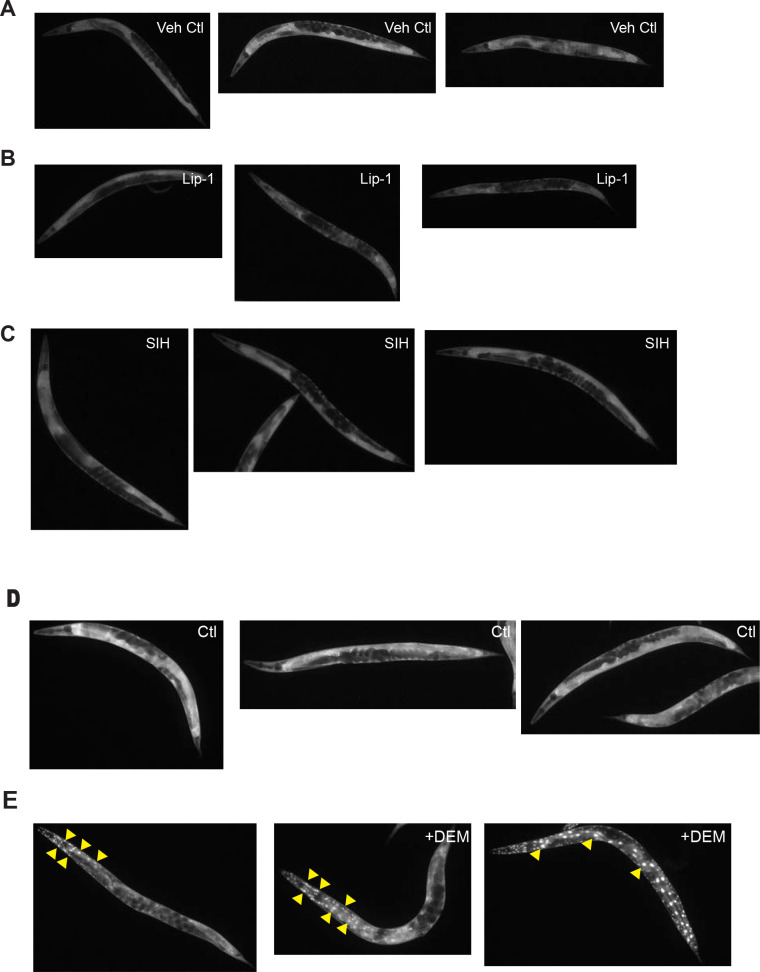
DAF-16 nuclear localization: The DAF-16 reporter strain TJ356 (zIs356 [Pdaf-16::daf-16a/b::gfp + rol-6(su1006)] was used to visualize nuclear localization of the DAF-16 transcription factor as an indicator of insulin-like signalling.Images of control (Ctl), 200 µM Lip-1 and 250 µM SIH-treated animals are shown in A to C. DEM-treated (±10 mM DEM) animals are shown in D and E. Lip-1 and SIH do not cause nuclear translocation of DAF-16. Representative fluorescence micrographs of DAF-16::GFP localization in animals treated from L4 larval stage for 48 hr at 25°C. Shown are (A) 0.5% (v/v) DMSO vehicle control (Veh Ctl), (B) 200 µM Lip-1 (Lip-1) and (C) 250 µM SIH (SIH), which all show unaltered cytoplasmic localization of DAF-16. In contrast, glutathione depletion by DEM causes nuclear translocation of DAF-16. Representative fluorescence micrographs of DAF-16::GFP localization in animals (D) untreated (Ctl) or (E) animals exposed to 20 mM DEM for 6 hr at 25°C treated from L4 larval stage for 48 hr at 25°C.